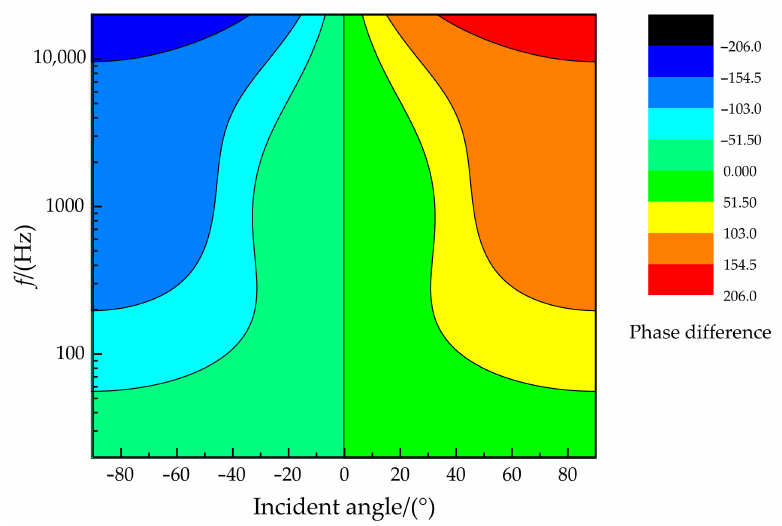
Figure 7. The relationship diagram of phase difference, incident angle, and frequency.